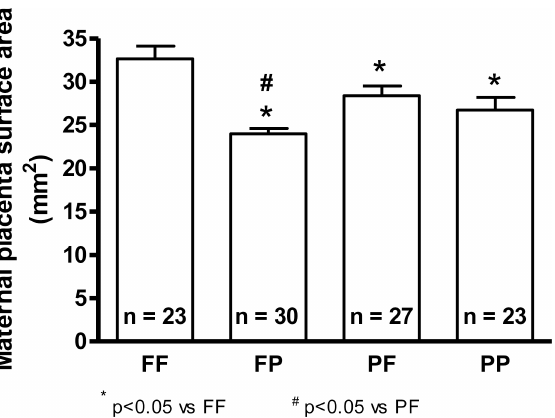
Fig 1. Surface area of the maternal placenta. FF = filtrated air before and duringpregnancy, FP = filtrated air before and pollutedair duringpregnancy, PF = pollutedair before and filtrated air duringpregnancy, PP = pollutedair before and duringpregnancy. * p < 0.05vs. FF. #p < 0.05vs.